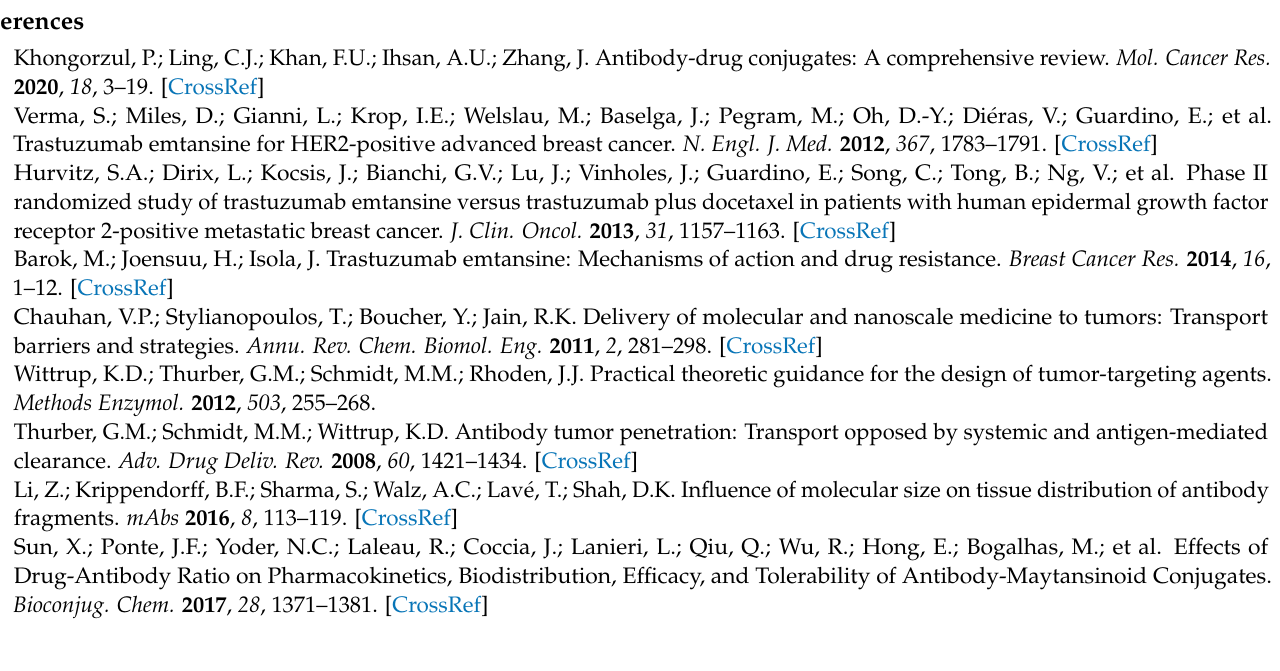
Figure S2: Characterization of Z Taq -ABD-mcDM1. Figure S3: Biosensor analysis; Table S1: